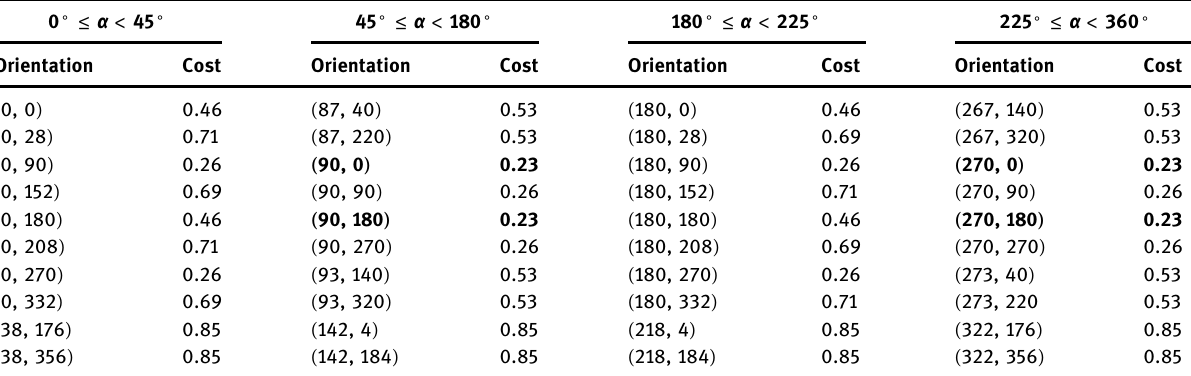
Table 4: Evaluation of critical points for case 1 α 0 45 ≤ < ∘ ∘ α 45